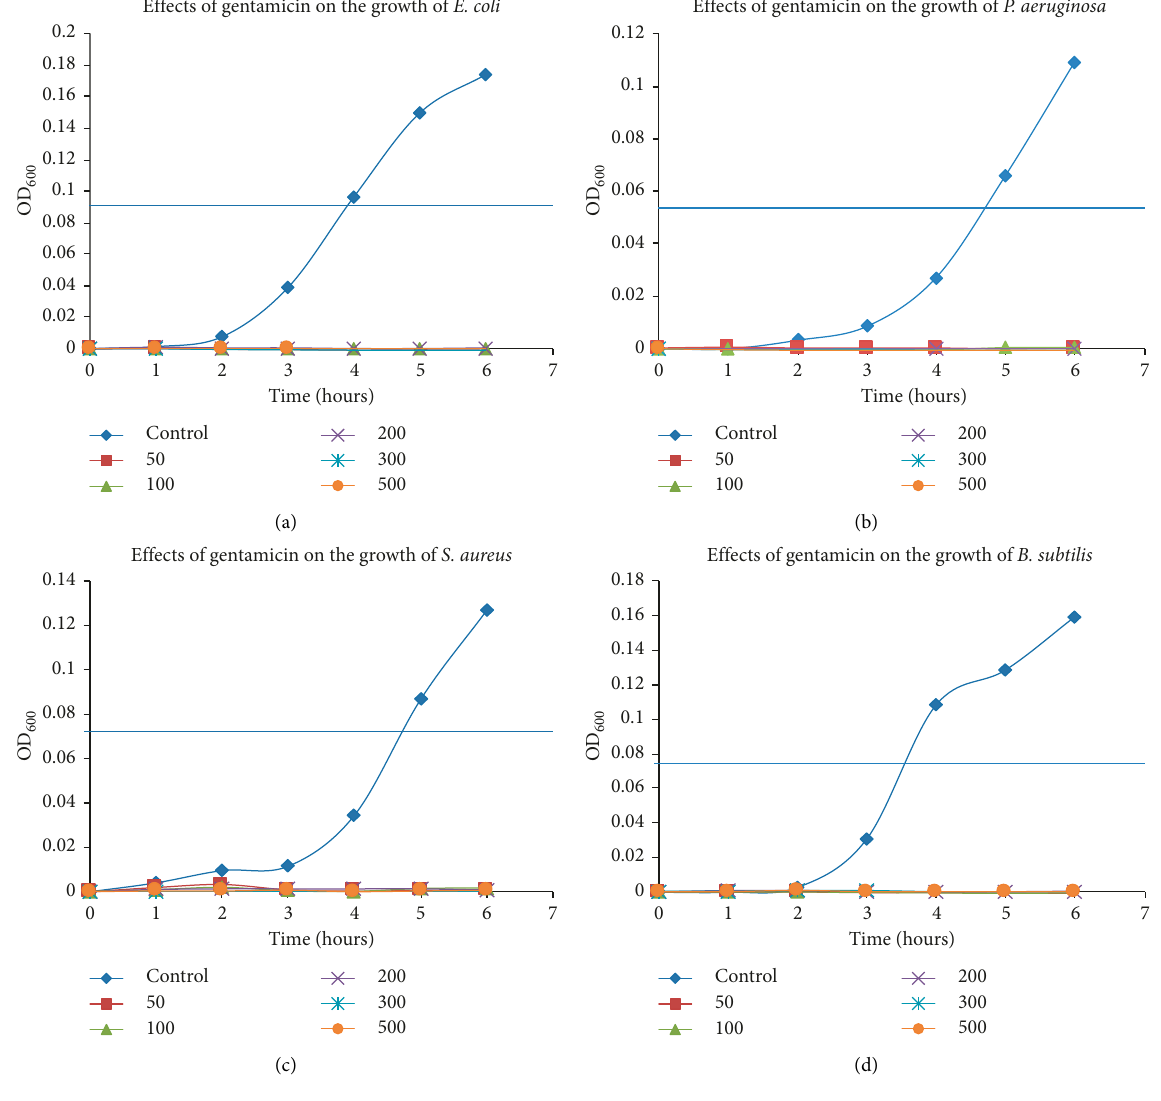
Figure 4: Effects of different concentrations of gentamicin against different time points. All compound concentrations are in µ g/mL. Table 2: Concentration of compounds required to reduce bacterial growth by 50% in comparison with control gentamicin. Compound